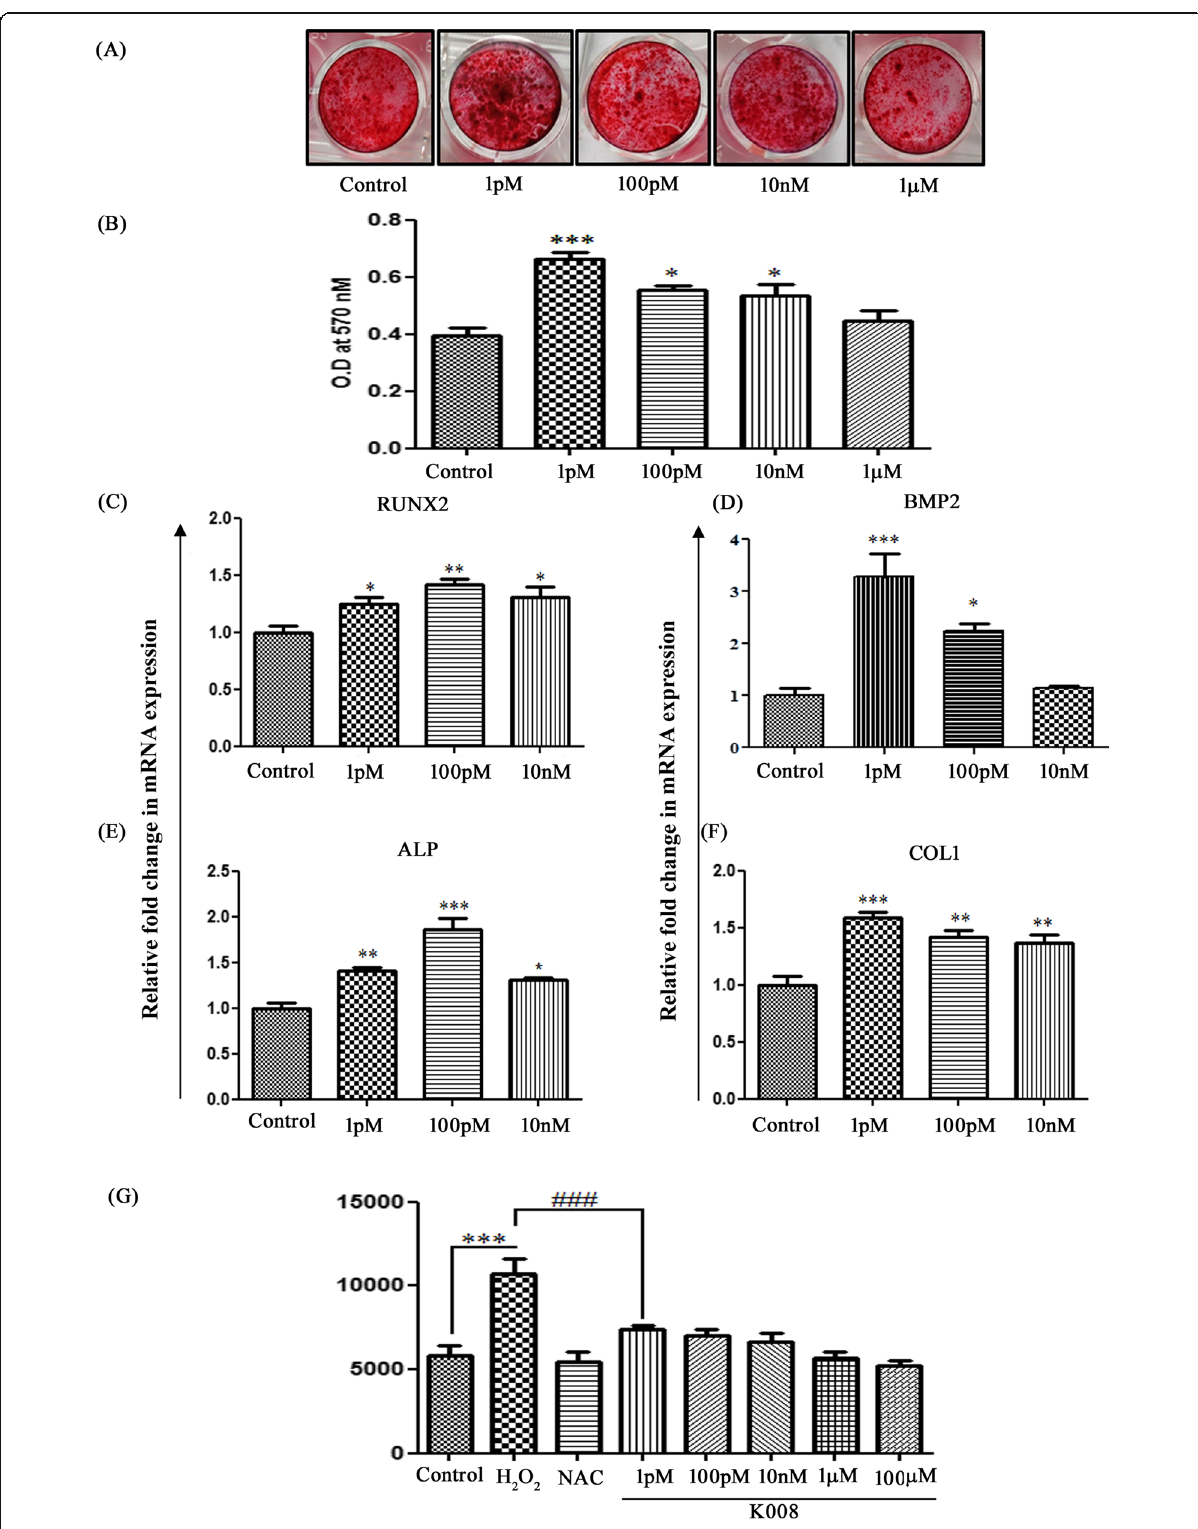
Fig. 6 (See legend on next